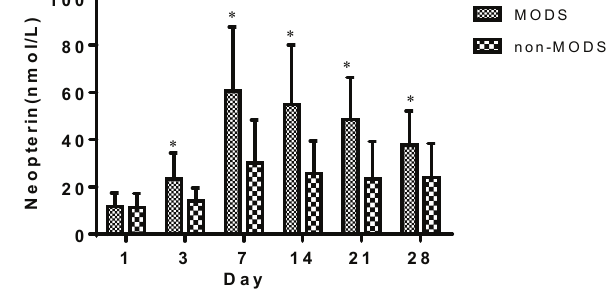
Figure 2: Bar plot of serum neopterin comparison between MODS and non-MODS groups in PBDs 1 to 28.